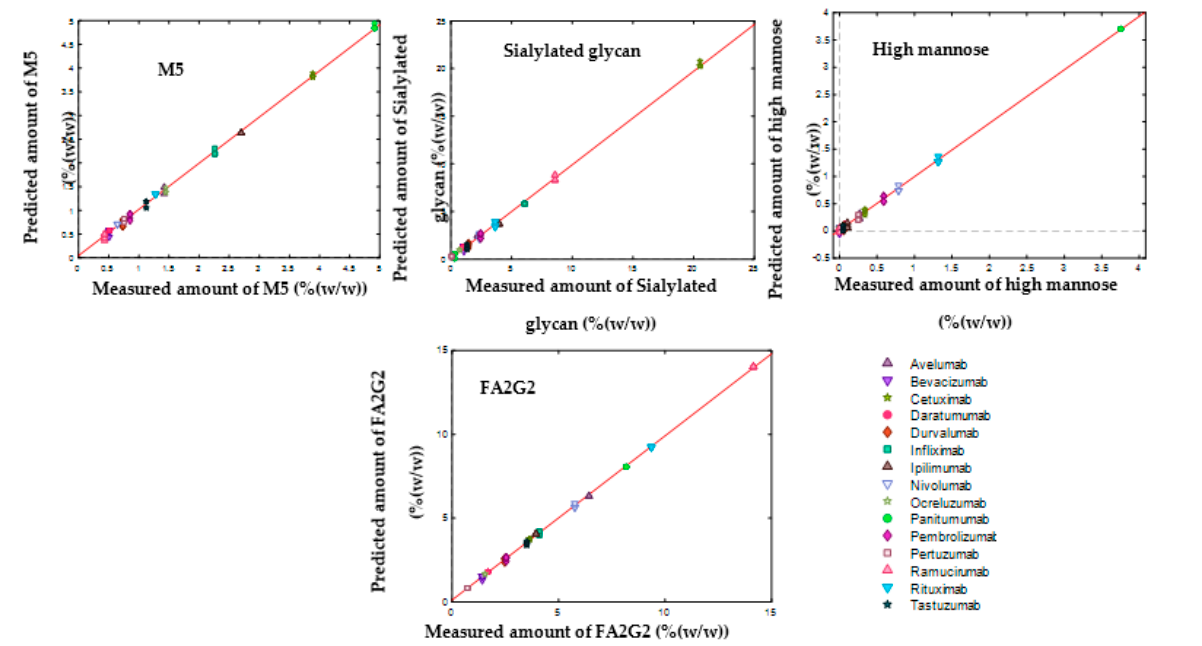
Figure 9. Measured versus predicted amounts of monosaccharides obtained by SVR regression be- tween 800 and 1150 cm − 1 for the analysis of the amount of each monosaccharide at low concentra- tion (3 mg mL − 1 ) of mAbs.